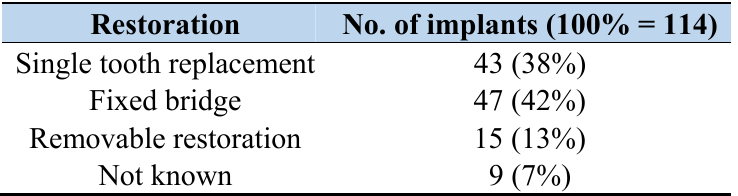
Table 3. Prosthetic